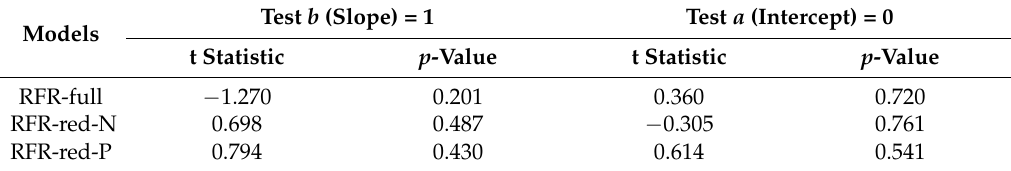
Table 5. Regression parameters and hypothesis testing for the RFR models (Degree of freedom = 79).